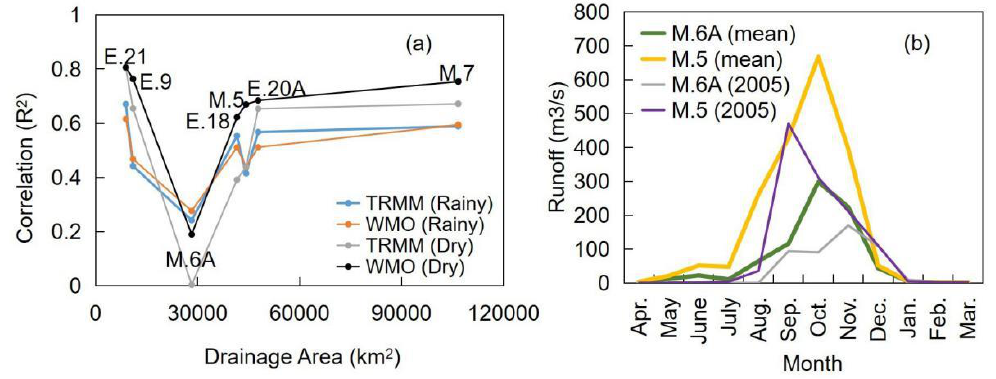
Figure 5. The monthly runoff at seven hydrological stations in the mainstream of Mun-chi river from 2003 to March 2008: ( a ) The correlation of runoff simulations based on WMO and TRMM precipitation river; ( b ) the comparison between of measured runoff at M.6A and M.5 in 2005 hydrological year.